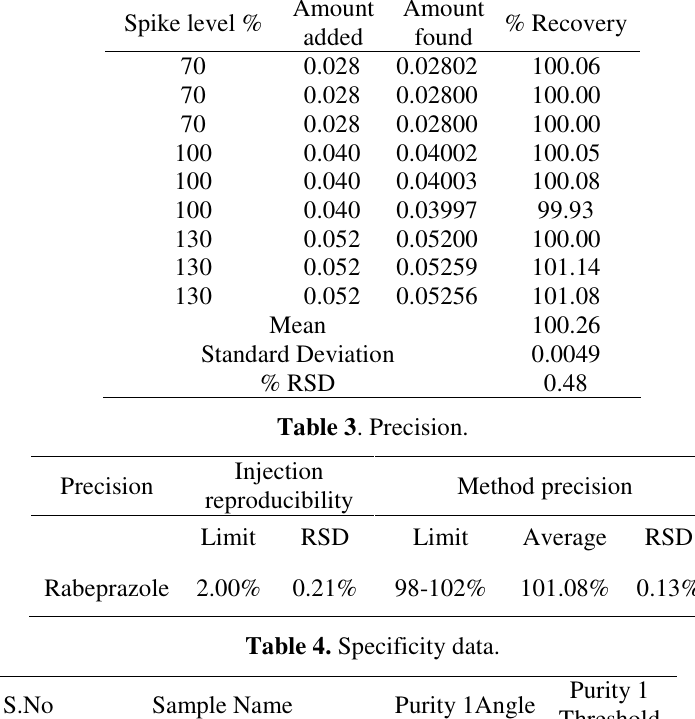
Table 2 . Accuracy results of recovery experiments.